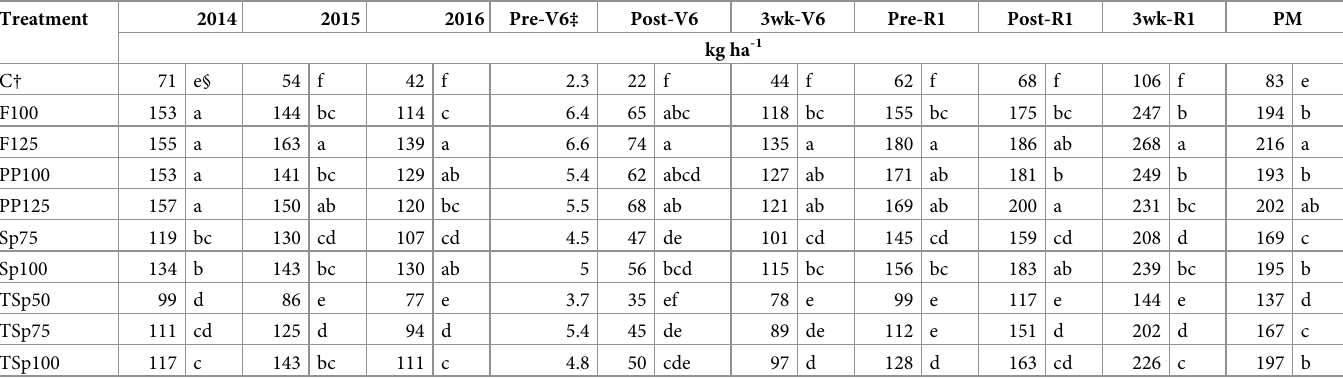
Table 7. Treatment × year and treatment × time of sampling for maize tissue N uptake at Lamberton 2014–2016. Treatment